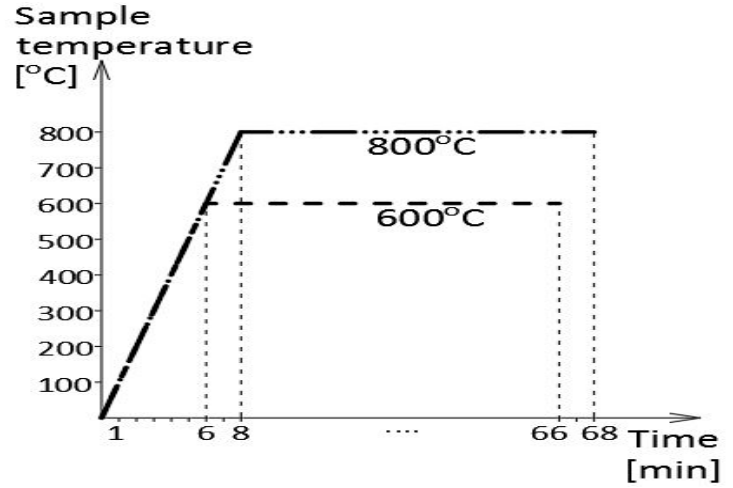
Figure 1. The initial thermal treatment of samples simulating the fire action (according to [7]).